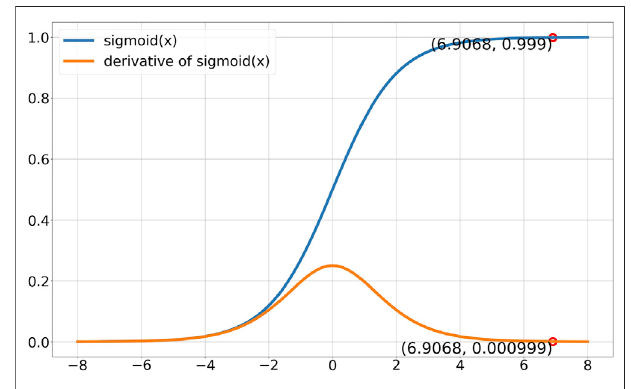
FIGURE 1 | Sigmoid